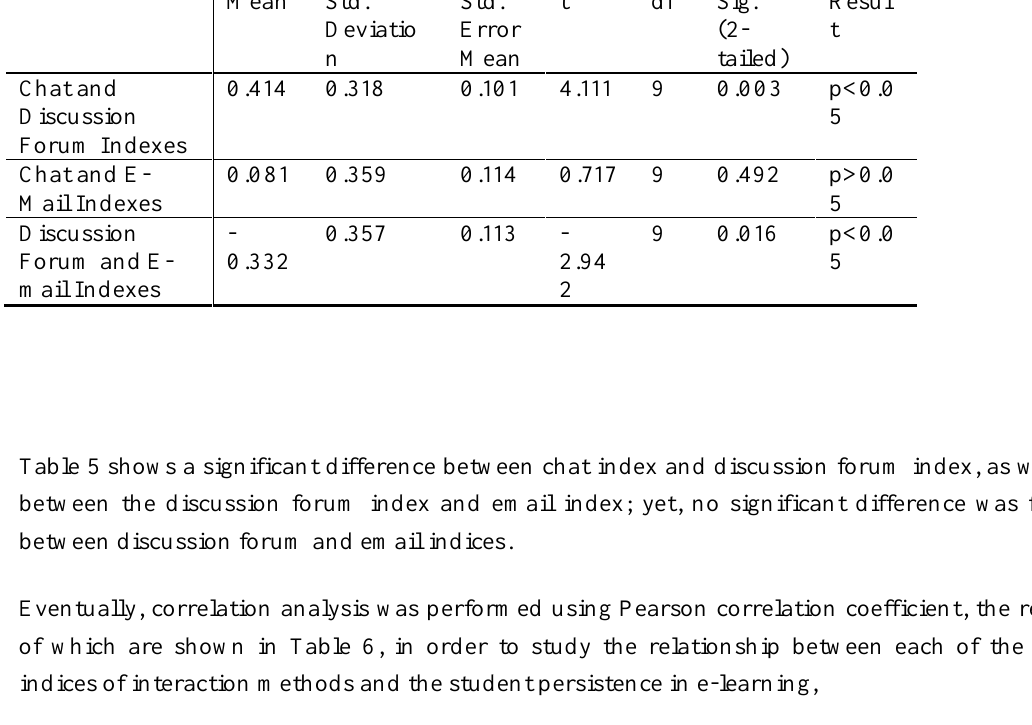
Differences Between the Three Indices of Interaction Methods Mean Std.